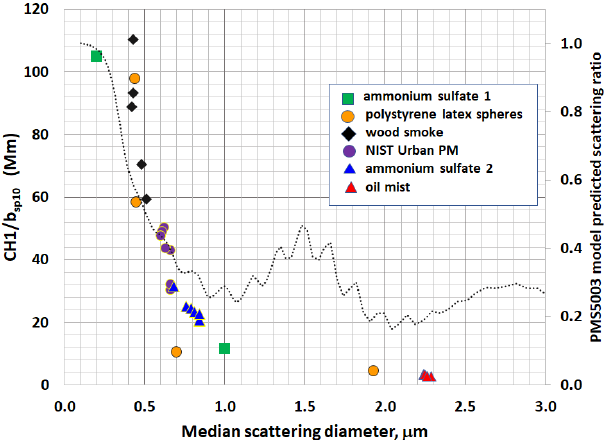
Figure 10. Laboratory measurements of CH1 /b sp10 versus median scattering diameter from Tryner et al. (2020) and He et al. (2020). Results are compared with PMS physical–optical model prediction of the scattering ratio (yellow line in Fig. 7). The maximum value of 1.0 of the model-predicted scattering ratio is arbitrarily set at a CH1 /b sp10 value of 110Mm. Ammonium sulfate 1 data are from He et al. (2020); all other data are from Tryner et al. (2019, 2020).